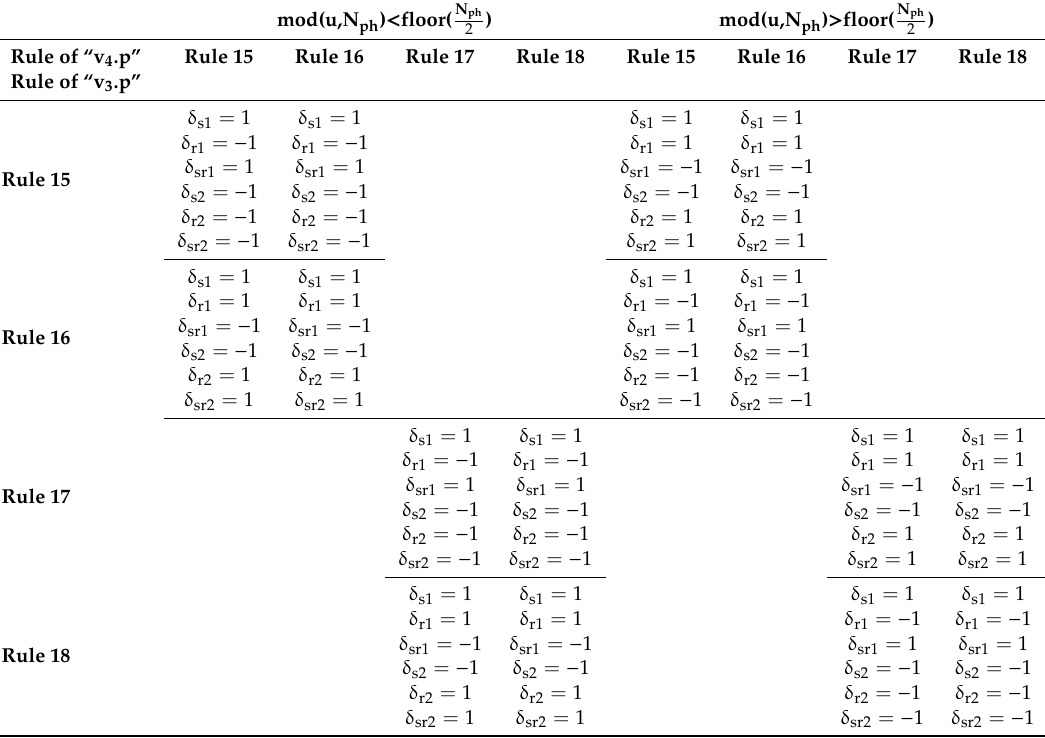
Table A2. Pulsating torque components due to interactions of harmonics of rules 15, 16, 17 and